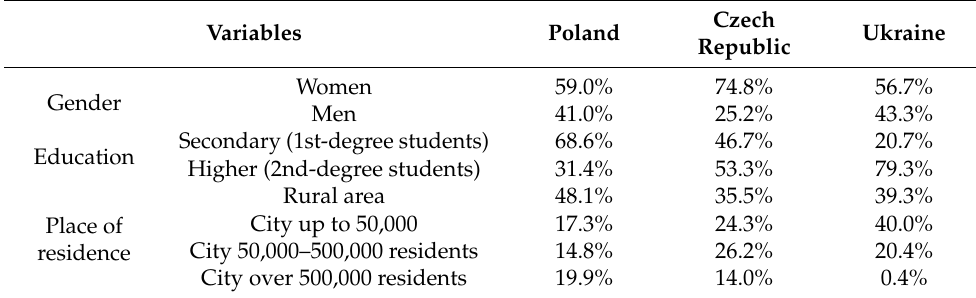
Table 2. Characteristics of the study